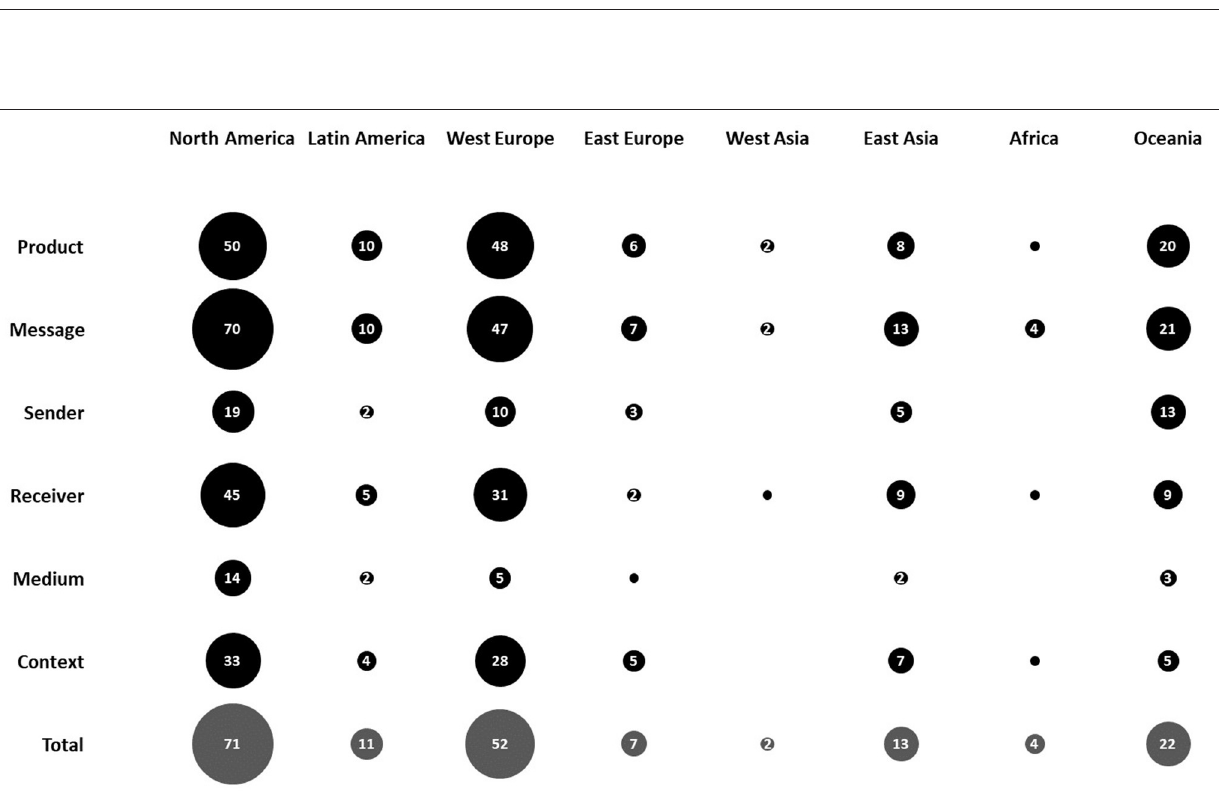
FIGURE 6 | Prevalence of empirical studies in each geographical region (i.e., North America, Latin America, West Europe, East Europe, West Asia, East Asia, and Oceania) during each period (i.e., 1954–2000, 2001–2005, 2006–2010, 2011–2015, and 2016–2019).